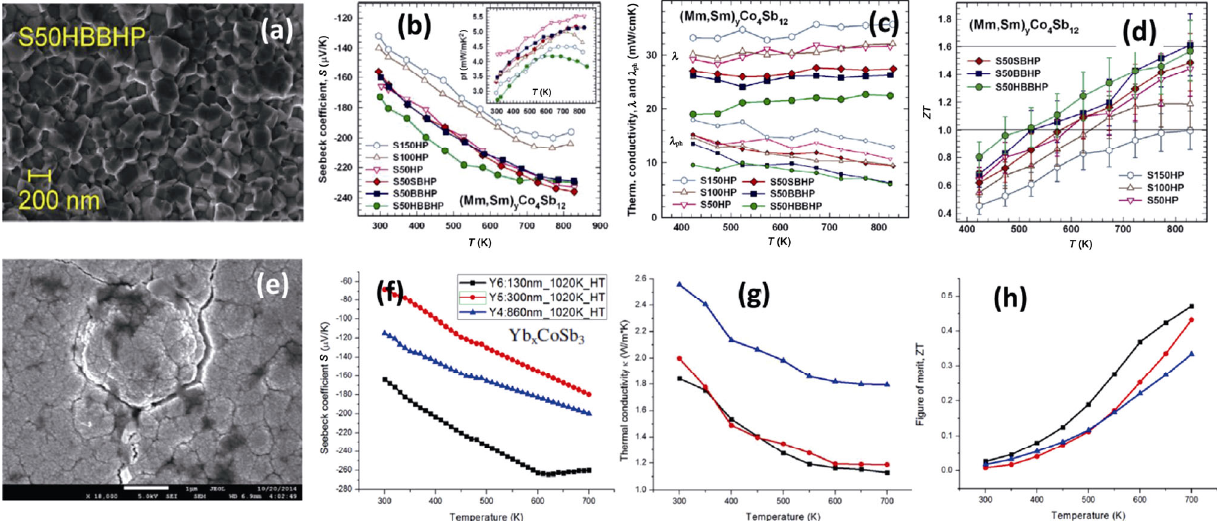
Fig. 7 CoSb 3 -based TE materials with low dimensional nanostructure. (a) SEM image of the broken surface of (Mm,Sm) y Co 4 Sb 12 (S50HBBHP sample); temperature dependence of (b) Seebeck coefficient, (c) thermal conductivity λ and lattice thermal conductivity λ ph , and (d) ZT values of n-type (Mm,Sm) y Co 4 Sb 12 ; the inset in (b) shows the temperature dependence of power factor. Reproduced with permission from Ref. [138], © Acta Materialia Inc. 2014. (e) SEM surface image of Yb x Co 4 Sb 12 thin film (1020 K heat treatment Y4 sample); (f) Seebeck of 1020 K heat treated Yb x Co 4 Sb 12 thin films with different thicknesses; (g) thermal conductivity of Yb x Co 4 Sb 12 film at different thicknesses with temperature dependent; (h) figure of merit, ZT values of Yb x Co 4 Sb 12 films with different thicknesses. Reproduced with permission from Ref. [142], © AIP Publishing LLC.